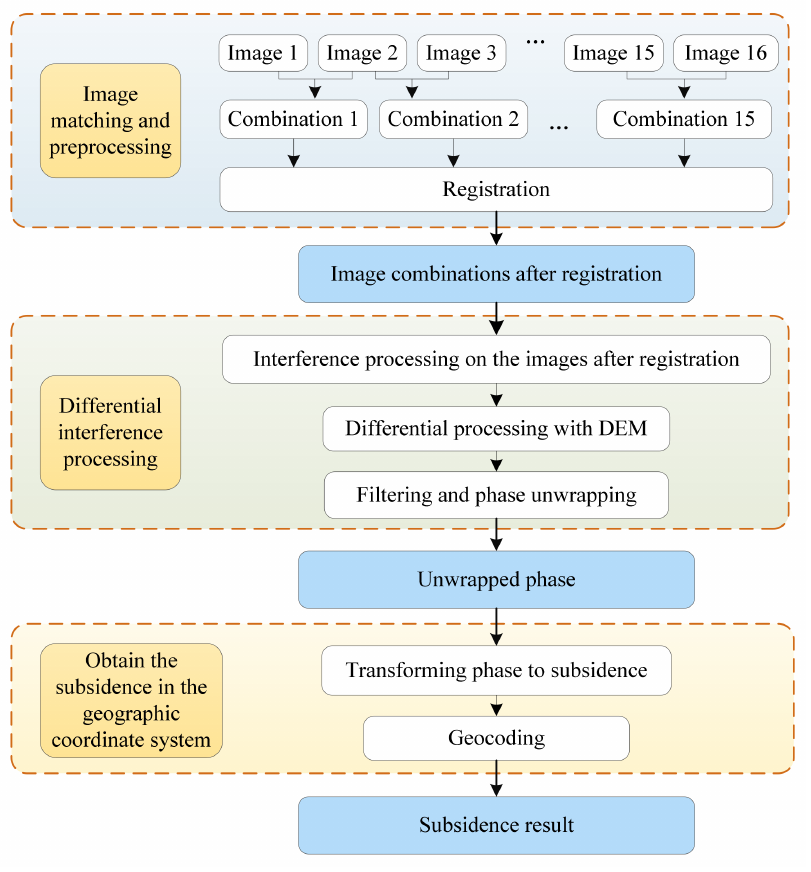
Figure 2. Data processing by